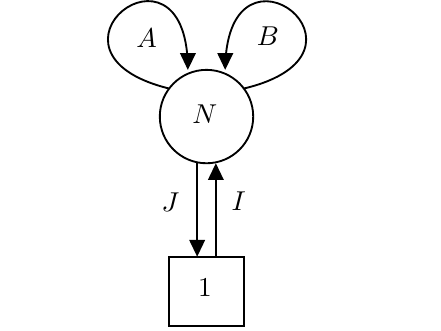
Figure 1. The Jordan quiver specifying the field content of 3d ADHM with one